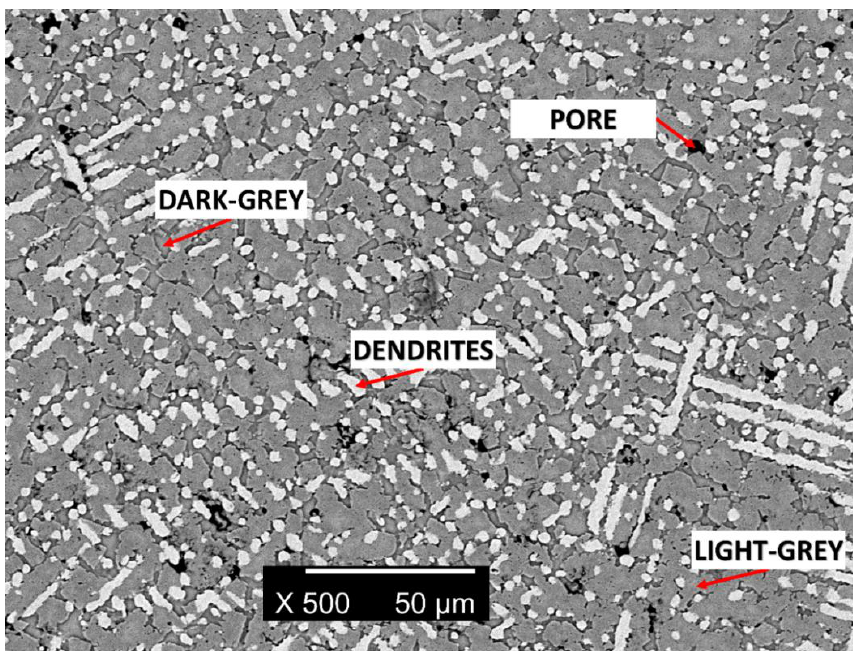
Figure 2. Backscattered electrons contrast image (BSE) of the sample microstructure with the assigned phases and pores.